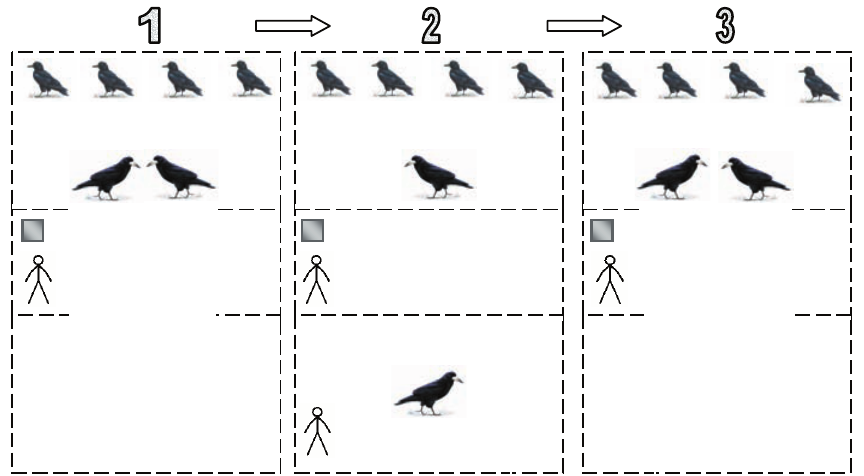
Fig. 1. Condition 1. Arrows show the three phases of the experiment: (1) pre-separation, (2) separation of the test subject (partner stays with group), (3) post-separation. The recording device is indicated by a square, experimenters are represented by figures. Dashed lines indicate wire mesh.